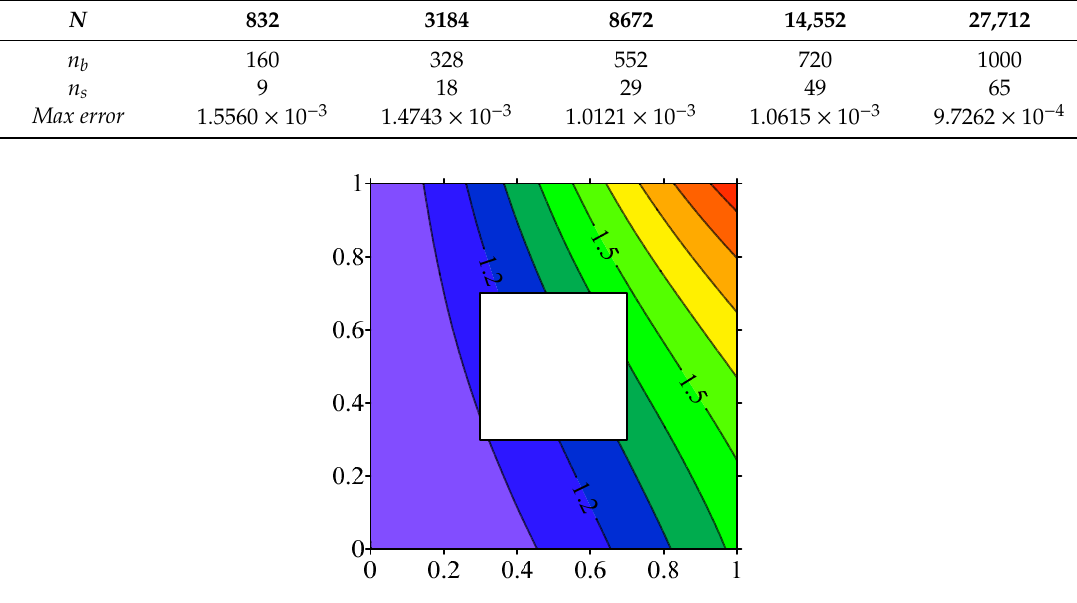
Table 6. Maximum absolute error for case 5.